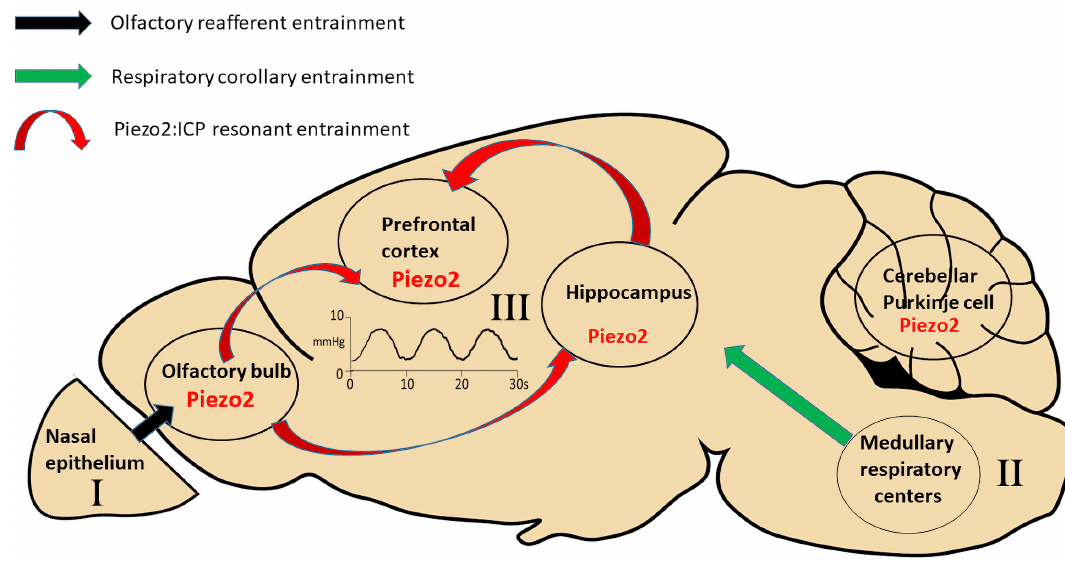
Fig.7. Differentmechanismsforrespiration-inducedentrainmentofneuralnetworksinwidelyspacedregionsofthebrain. Thefirstmechanism involves respiratory olfactory re-afferent discharge (ORD). It originates in the nasal epithelium, where primary olfactory neurons (PONs), which express olfactory G protein-coupled receptors (GPCRs) that are also mechanosensitive, can detect the nasal airflow pressure changes associated with nasal breathing. The PONs, through their direct synaptic connections (black arrow) with mitral cells and tufted cells in the OB, cause respiratory entrainment of the neural activity within the OB. In turn, the OB entrains neural activity in the hippocampus and prefrontal cortex through their monosynaptic and/or polysynaptic connections (not shown) with these brain regions. The second mechanism depends upon respiratory corollary discharge (RCD) arising from the neurons in themedullaryrespiratorynucleithatcontrolthediaphragmmusclesandsendefferentcopydischargestohighbrainregions(e.g., hippocampusandneocortex) via yet to be identified synaptic pathways. The third mechanism, intrinsic resonance discharge (IRD), depends upon the pressure-sensitive channel, Piezo2, expressed in mitral cells of the OB and pyramidal cells of the hippocampus and neocortex. Piezo2, based on its demonstrated high sensitivity to low-pressure pulses ( ≤ 5 mmHg, is proposed to transduce the ICP pulse associated with the respiratory cycle, thereby providing a synchronizing clock for brain activity. Finally, Piezo2 expression shown in cerebellar Purkinje cells may explain the Purkinje cell’s sniffing-dependent activation in the human